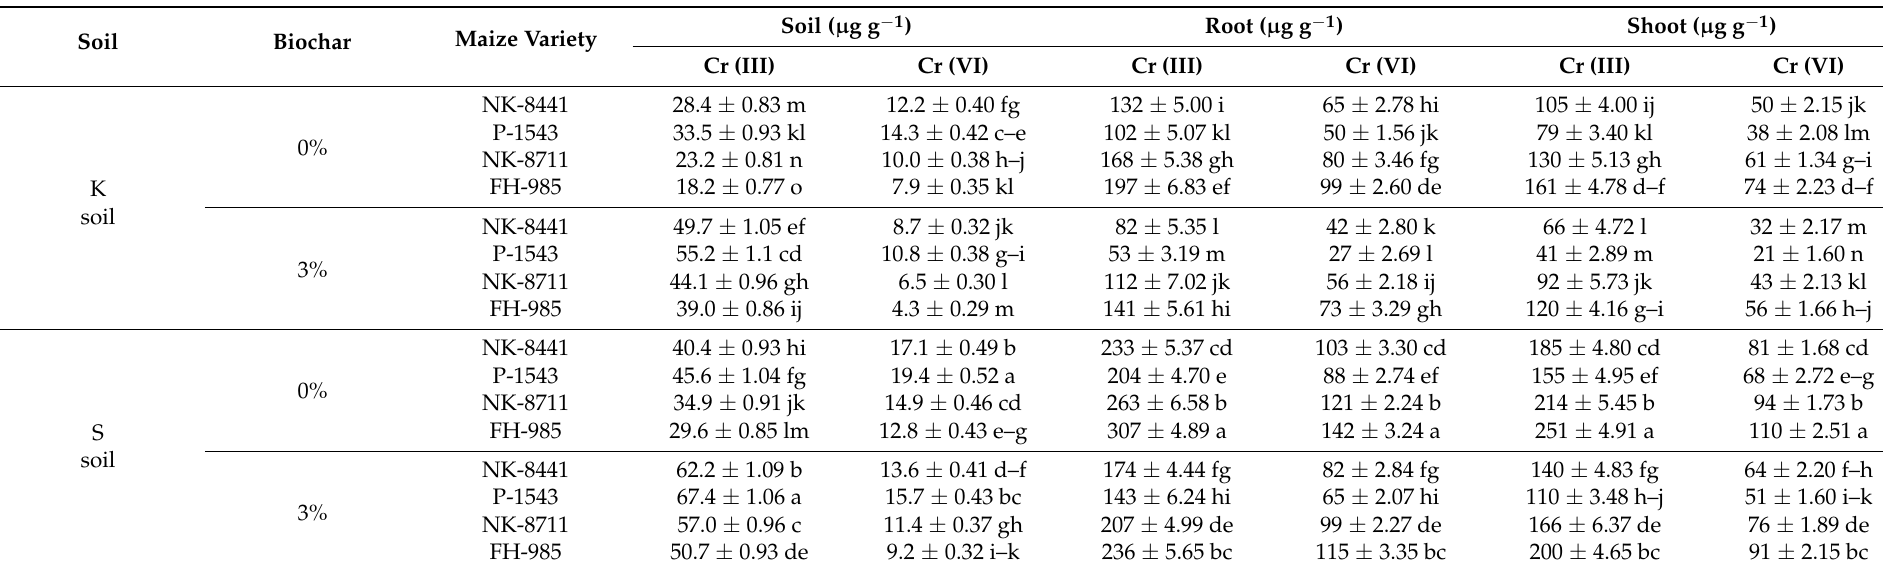
Table 6. Chromium concentration in soil, root, and shoot of studied maize cultivars NK-8441, P-1543, NK-8711, and FH-985 with the application of biochar in tannery polluted Kasur and Sialkot